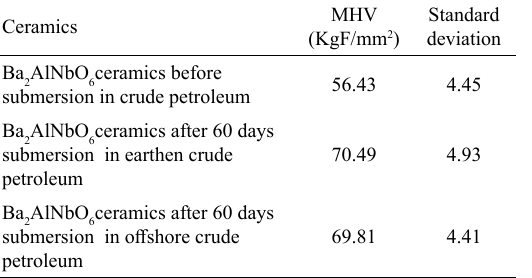
Table 2. Vicker's microharness of Ba after submersion in crude petroleum for 60 days.